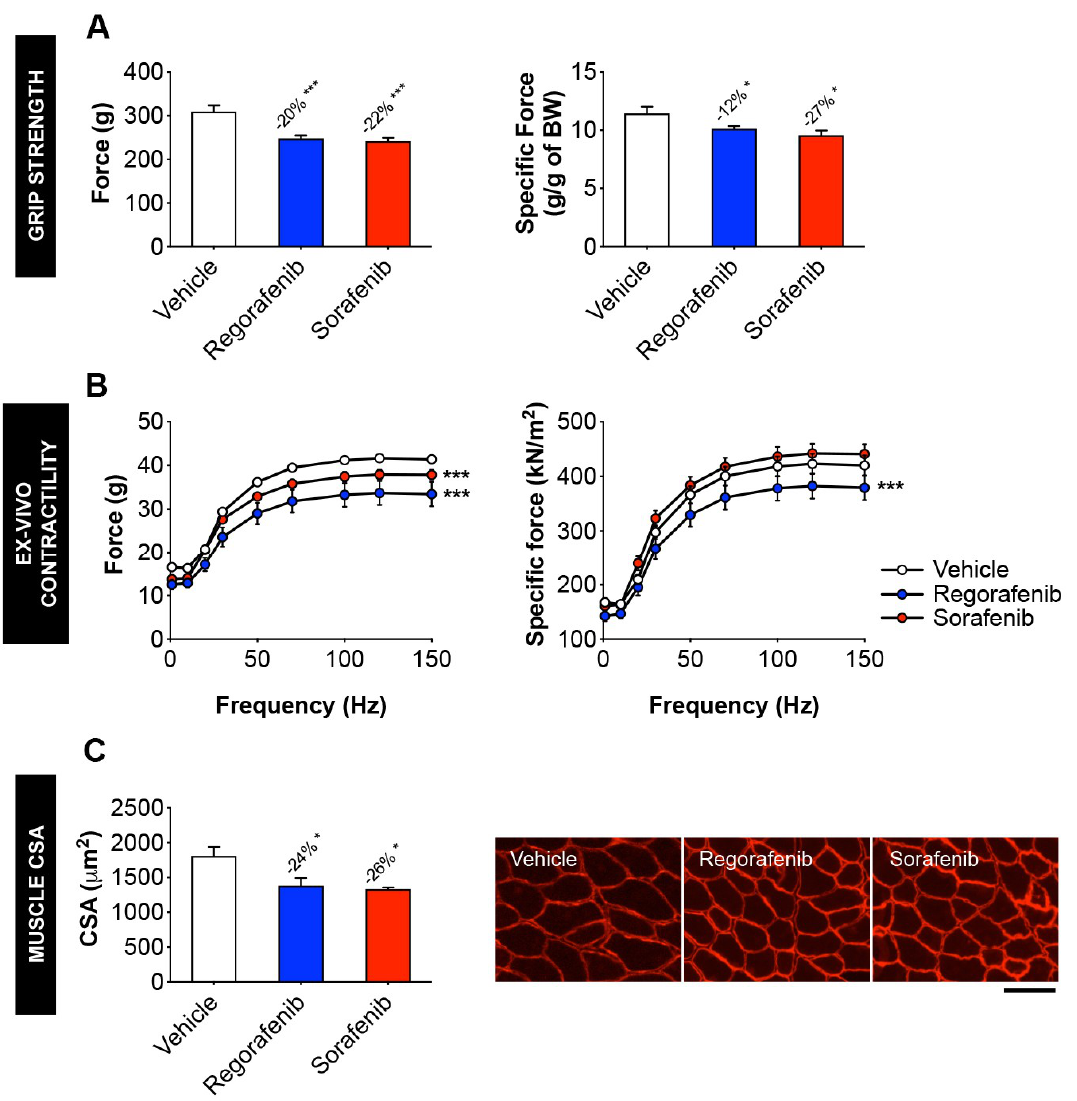
Figure 2. MKIs promote skeletal muscle weakness. ( A ) Assessment of grip strength, reported as absolute force (expressed in grams) or specific force (expressed relative to body weight (BW)) in mice treated with 30 mg / kg / day regorafenib (blue; n = 8), 60 mg / kg / day sorafenib (red; n = 8), or vehicle (white; n = 8) over the course of 6 weeks. ( B ) Assessment of whole muscle contractility of EDL muscle, reported as absolute muscle force (expressed in grams) and specific force (expressed as kN / m 2 ). ( C ) Cross-sectional area (CSA) of tibialis anterior muscles and representative CSA image of tibialis anterior muscle sections stained with anti-dystrophin antibody. Images taken at 20 × , scale bar equals 100 µ m. Data presented as mean ± SEM. Significance of the difference: * p < 0.05, *** p < 0.001 vs. Vehicle.